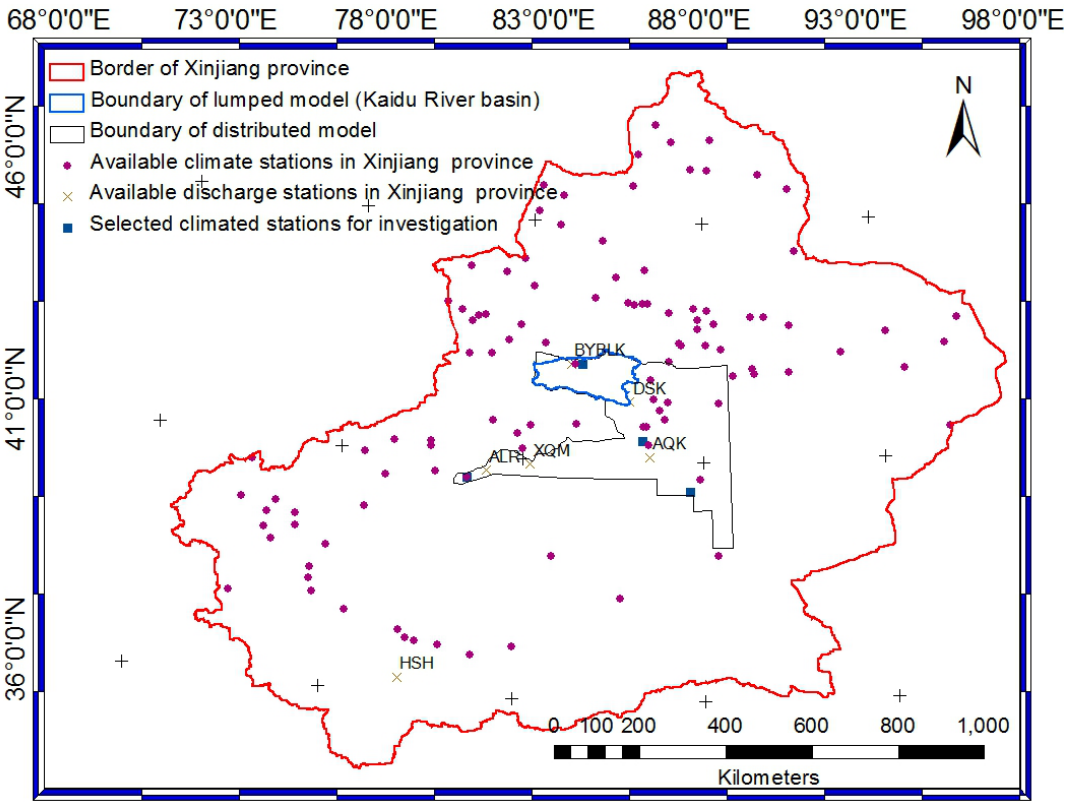
Fig. 1. Location of the Kaidu river basin in the Xinjiang province, the climate stations and discharge stations (based on the map of Xinjiang Uygur Autonomous Region, certificate No. GS(2007)268). The area simulated by the lumped conceptual models is represented by the blue polygon, while the area simulated by the spatially distributed model is surrounded by the black lines.